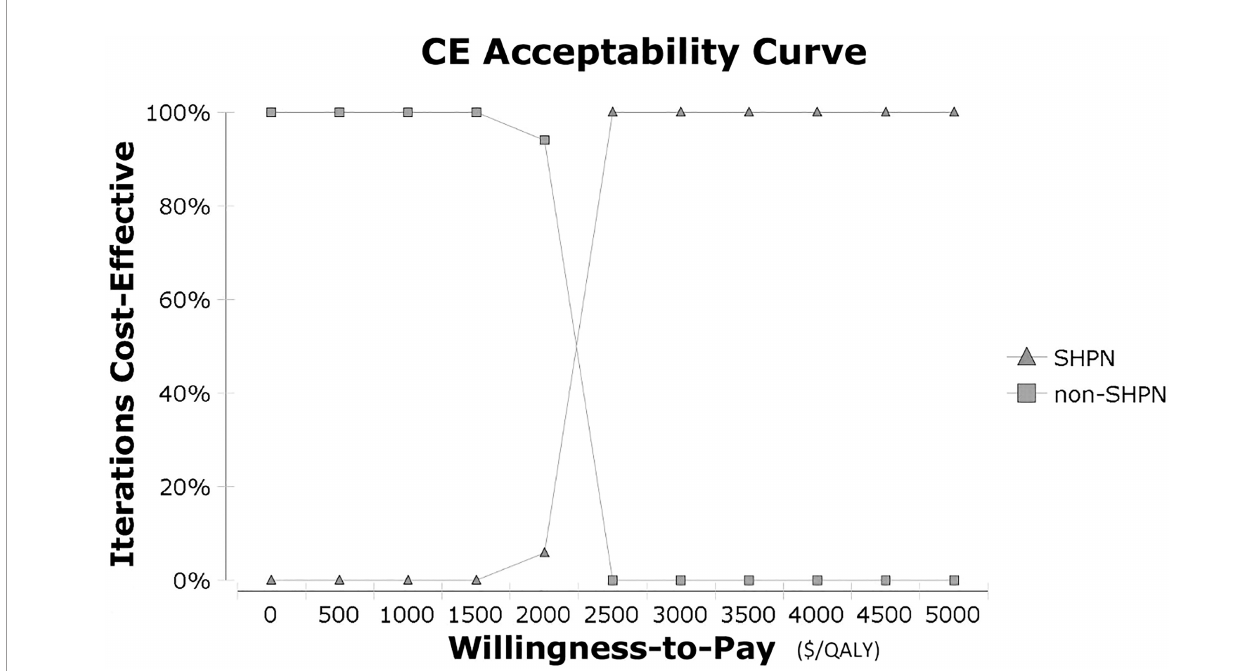
FIGURE 2 | Cost-effectiveness acceptability curve in probabilistic sensitivity analysis. CE, cost-effectiveness; QALY, quality-adjusted life year; sHPN, supplemental home parenteral nutrition.